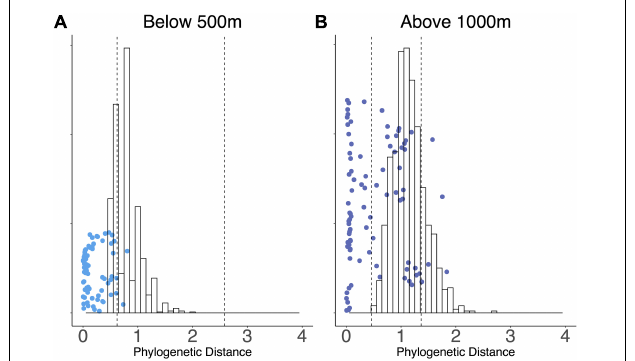
FIGURE 5 | Scatter plots show the distribution of pairwise phylogenetic distances (A) between indicator OTUs below 500 m, and (B) between indicator OTUs above 1,000 m. The histograms represent a bootstrapped distribution of 1,000 random draws from pairwise phylogenetic distances within the WM community, and 95% confidence intervals are indicated by vertical dashed lines. Each dot represents the phylogenetic distance between a pair of OTUs in that respective